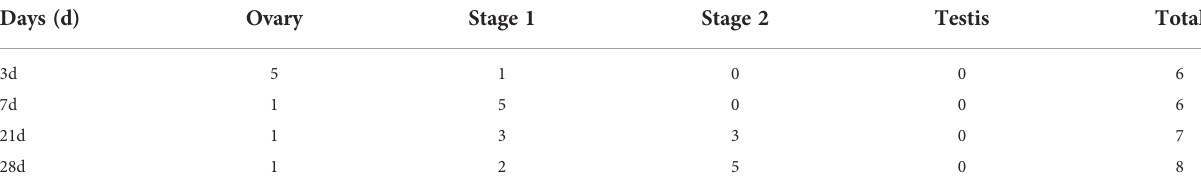
TABLE 4 Time course of the occurrence of intersex gonad in IP fi sh kept with fi ve smaller IP females.